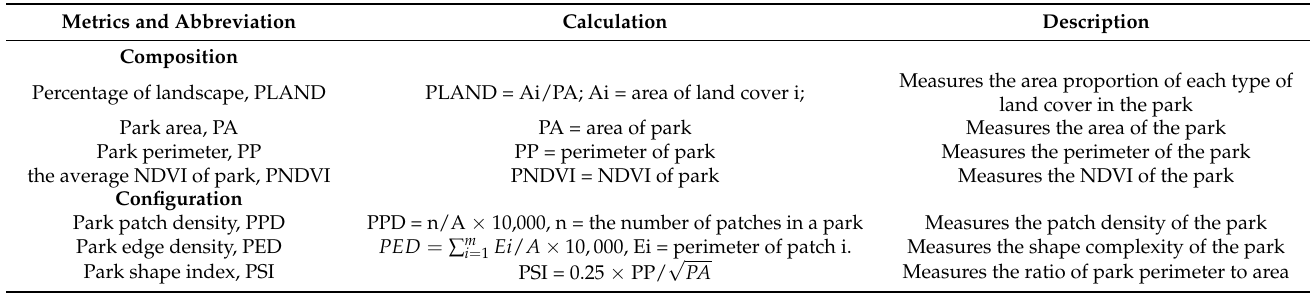
Table 1. Landscape metrics selected in this